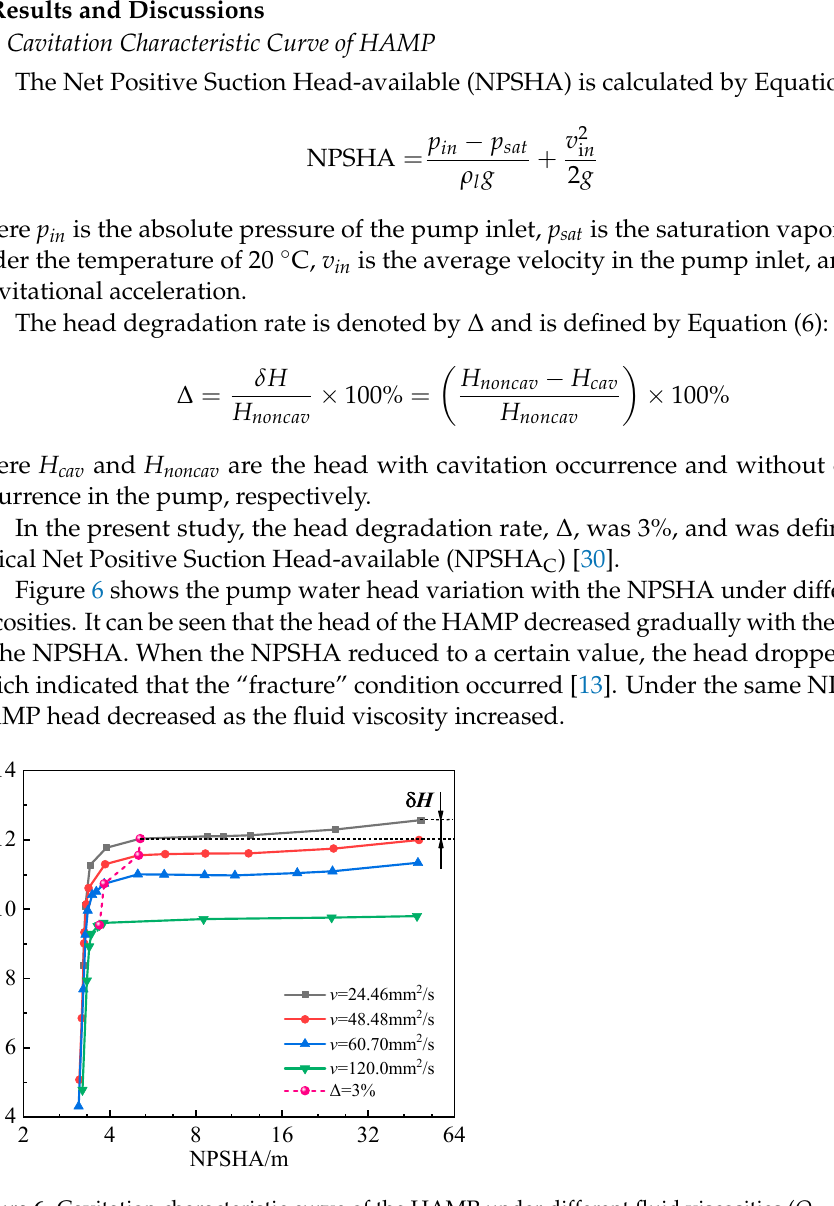
Figure 6. Cavitation characteristic curve of the HAMP under different fluid viscosities ( Q d = 100 m 3 /h, n = 4500 rpm).